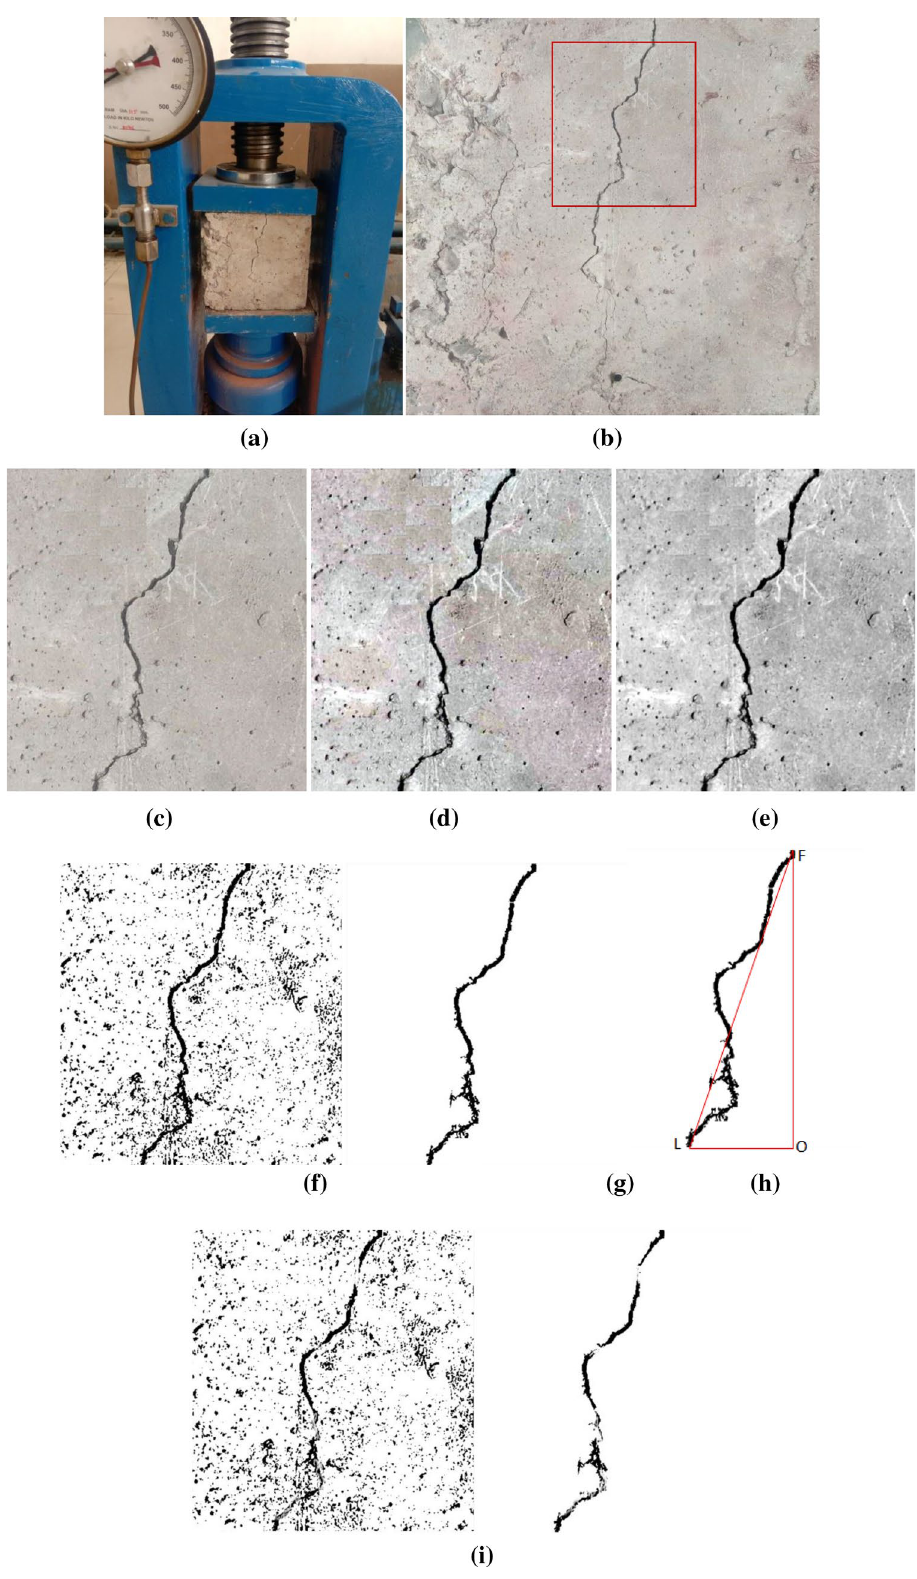
Figure 9. ( a ) Compression testing setup of CBC with major crack (b) Major crack developed and localised ( c ) Crack segment ( d ) Contrast stretched image ( e ) Gray scaled image ( f ) Noisy spectral clustered image ( g ) Noise-free crack ( h ) crack length measurement ( i ) Crack detection with spectral clustering method without